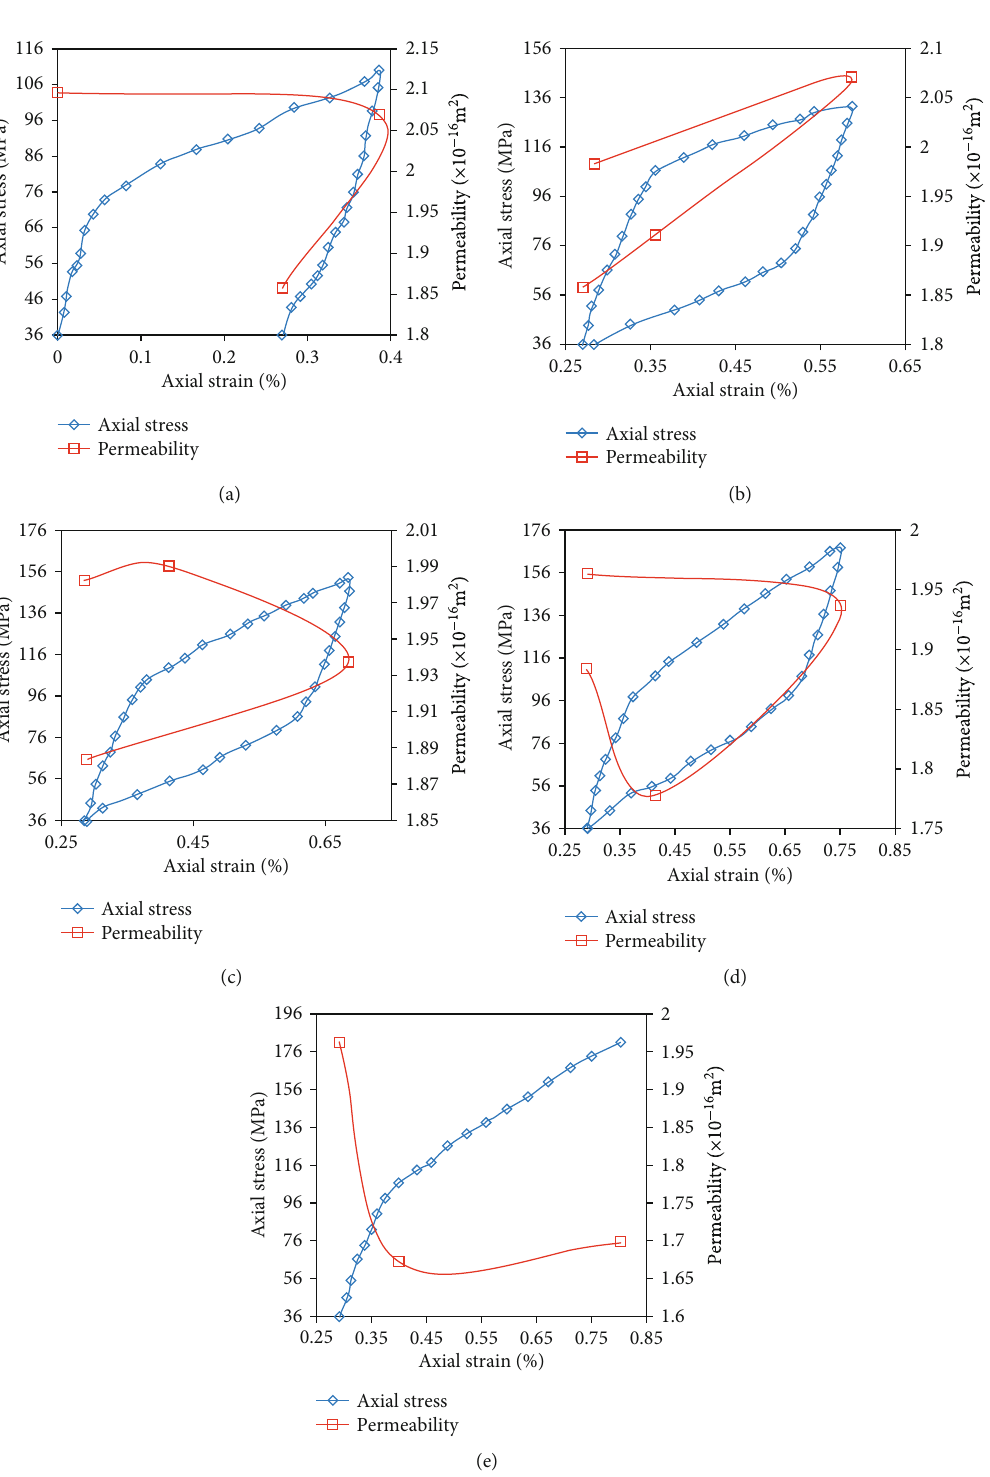
Figure 9: Stress-strain and permeability-strain curves for double-fracture sandstone at di ff erent cycles: (a) the fi rst cycle; (b) the second cycle; (c) the third cycle; (d) the fourth cycle; (e) the fi fth